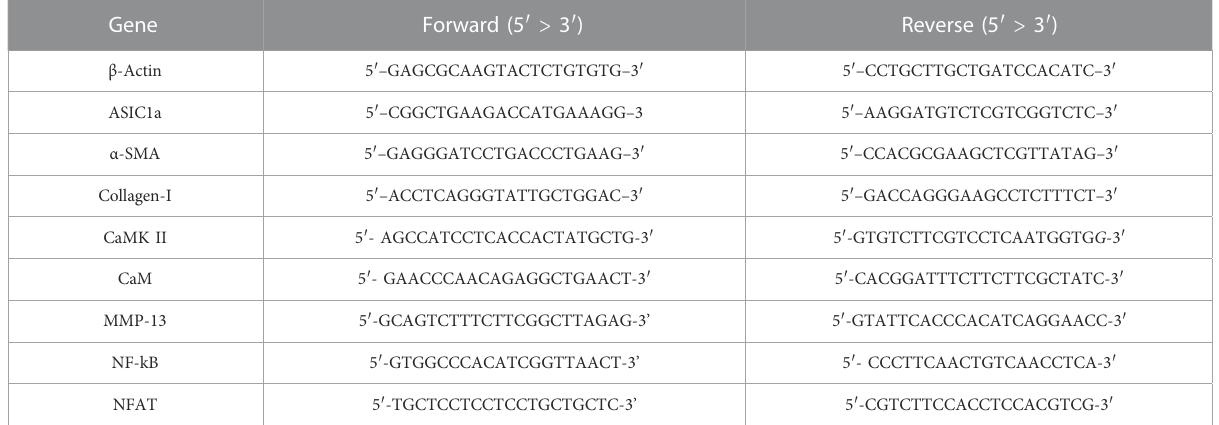
TABLE 1 Primer sequences of several genes for real-time PCR.